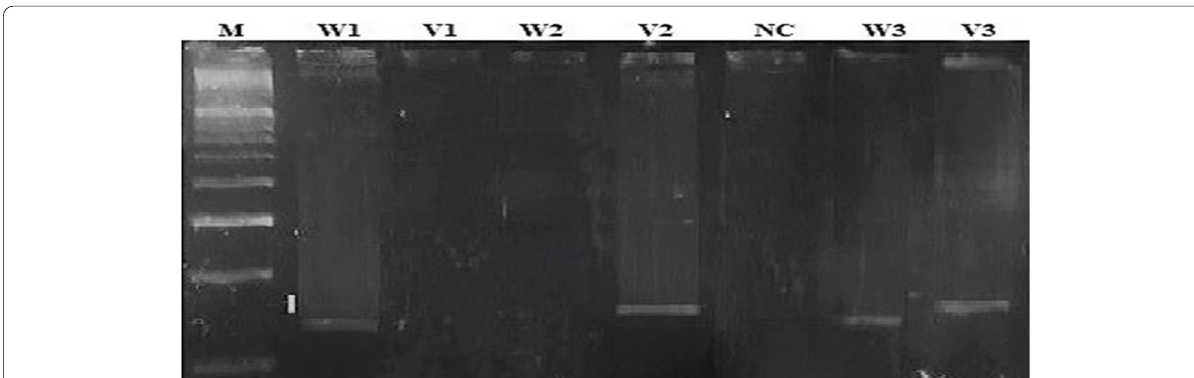
Fig. 3 Representative picture of AS-PCR products for detection of T790M mutation in exon 20 of EGFR gene. Two tube reaction in which lanes marked as “W” contain bands pertaining to wild allele and “V” contains bands pertaining to variant allele of same sample. “M” contains molecular marker (100 bp); “W1” contains 139 bp band pertaining to wild type allele, “V1” contains 146 bp band pertaining to mutant/variant allele; “NC” represents negative control